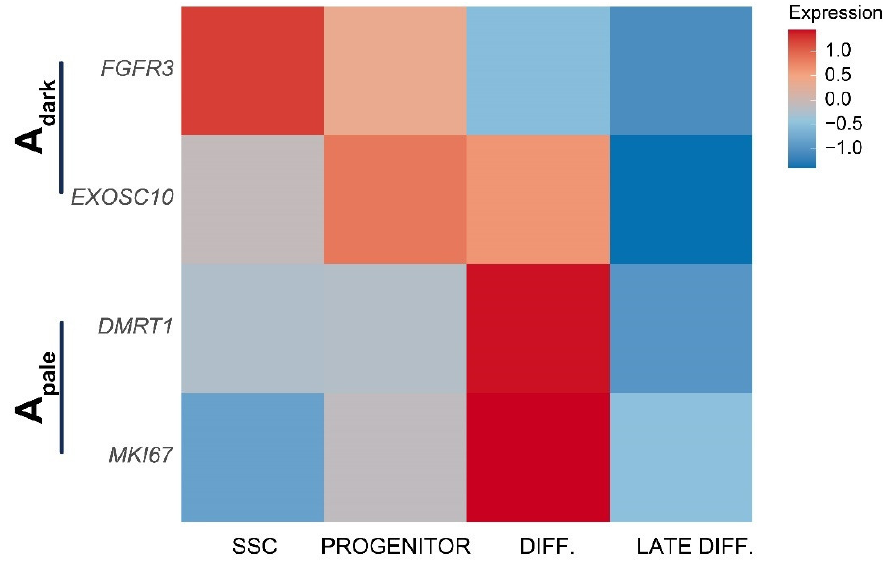
Figure 5. Marker expression of A dark and A pale spermatogonia in prepubertal human spermatogonia. Heatmap shows mRNA expression of A dark ( EXOSC10, FGFR3 ) and A pale ( MKI67, DMRT1 ) markers in human SSCs, progenitors, differentiating spermatogonia, and late differentiating spermatogonia (red is high, blue is low).